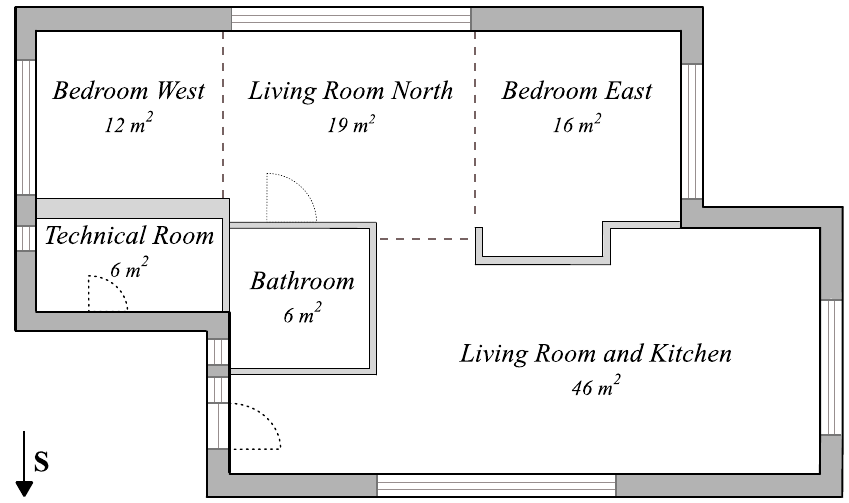
Figure 4. Floor plan of the studied building [15]. Table 3. Building envelope properties and energy system characteristics of the case study